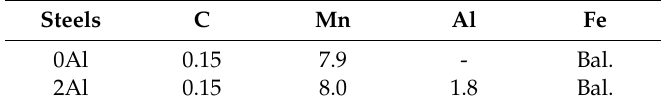
Table 1. Chemical compositions of medium Mn steels used in the present study